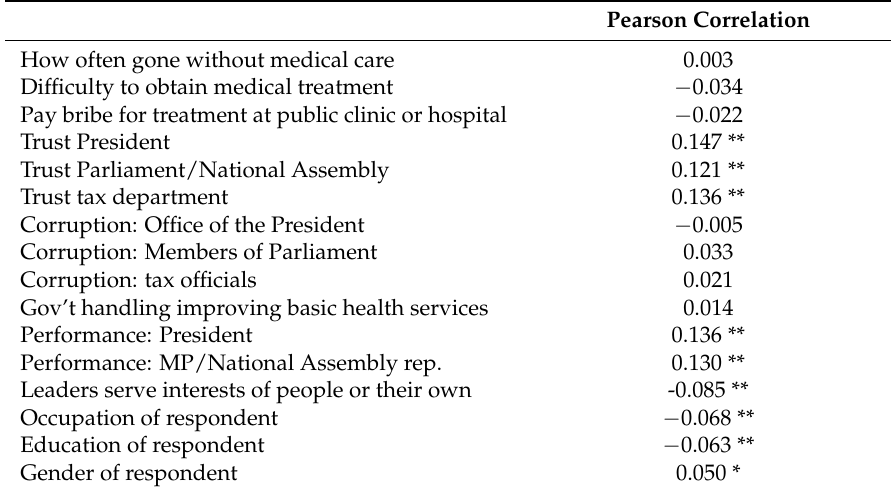
Pearson Correlation